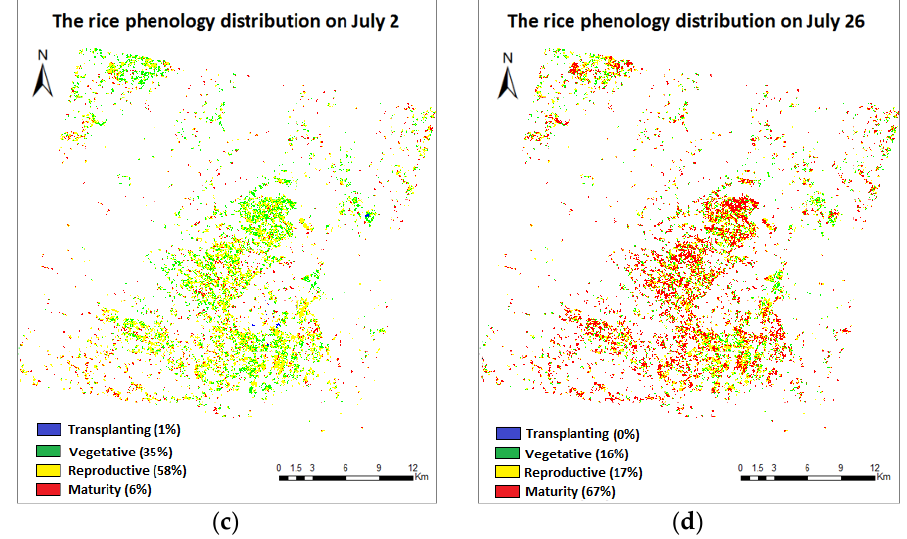
Figure 9. Map of rice phenological phases spatial distribution on ( a ) 15 May, ( b ) 8 June, ( c ) 2 July, and ( d ) 26 July. Blue, green, yellow, and red colors, respectively, represent transplanting, vegetative, reproductive, and maturity phases of rice plants in the study area.